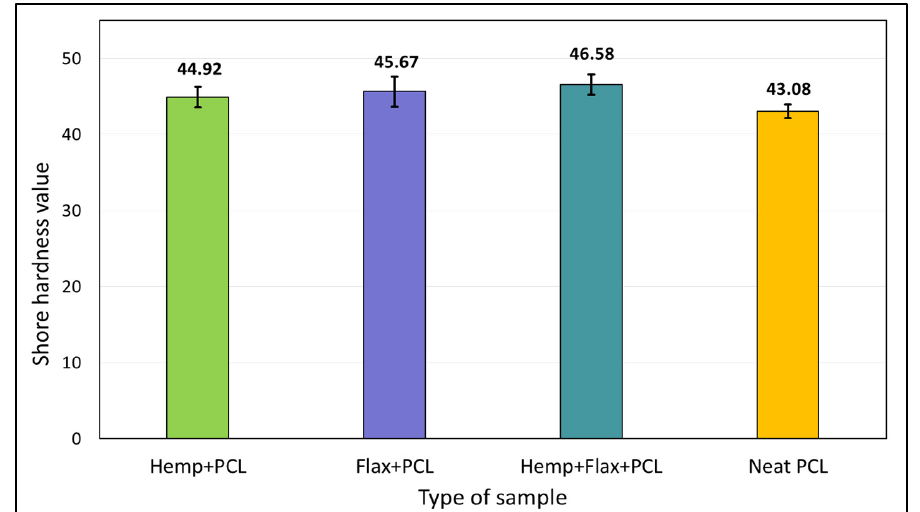
Figure 8. Shore hardness comparison of different samples.